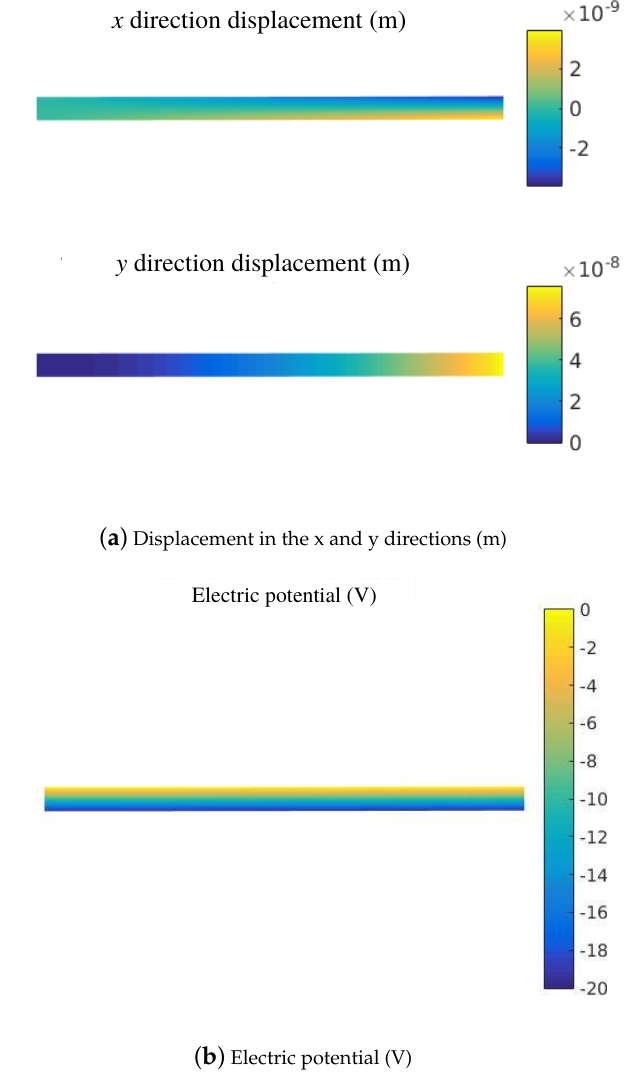
Figure 4. Calculation result of the cantilever beam under electric loading: ( a ) beam displacement; ( b ) electric potential